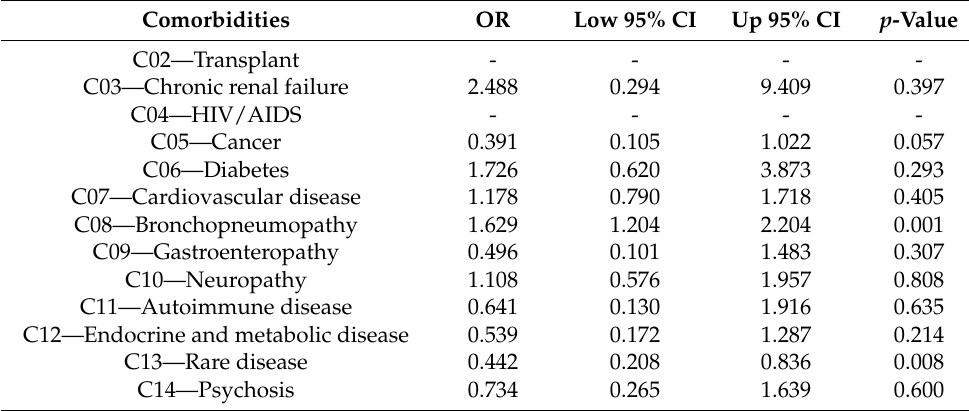
Table 3. Comorbidities implicated in ED access/hospitalization for varicella.